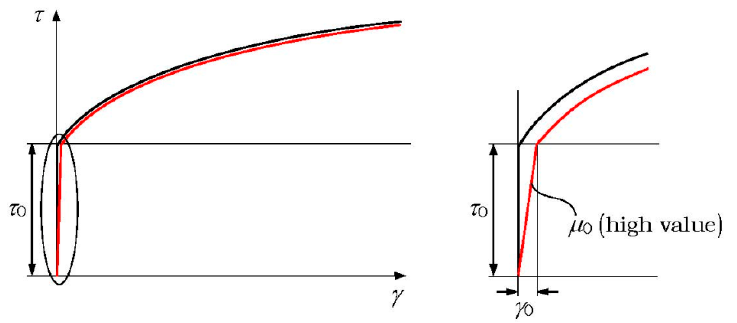
Figure 1. Herschel-Bulkley model for non-Newtonian fluid rheology.